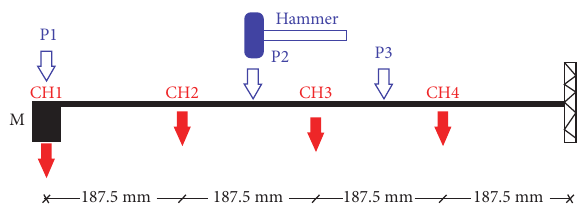
Figure 3: Location of exerted forces (P1, P2, and P3) and acceleration sensors (CH1, CH2, CH3, and CH4) in the studied